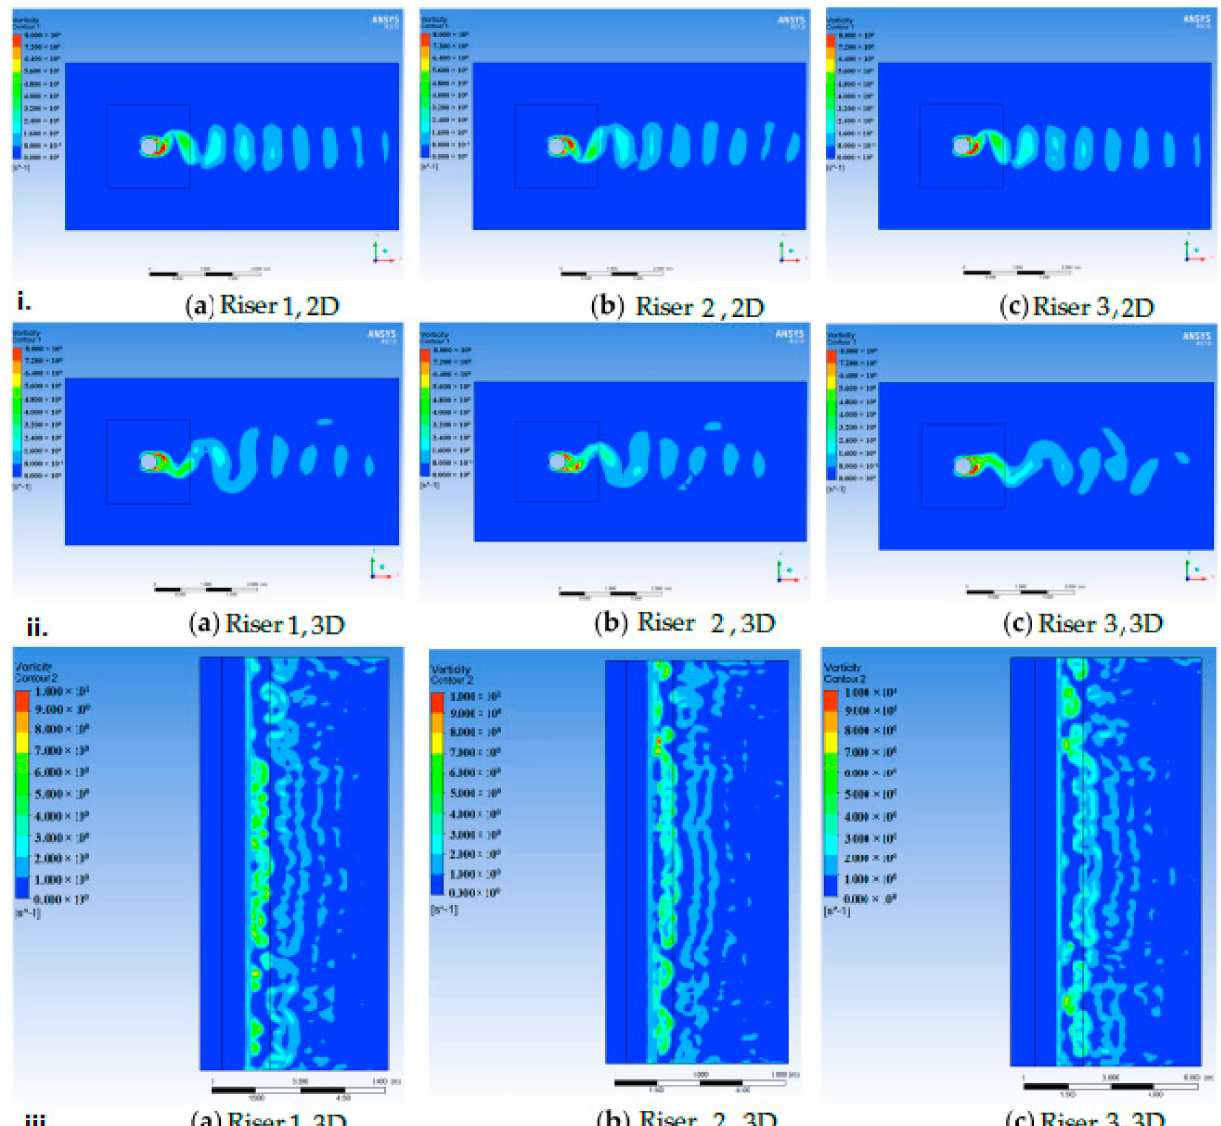
Figure 18. Profile of vorticity in 2D and 3D models for: Riser 1; Riser 2; and Riser 3. Here, ( ia – ic ) presents the vorticities for Risers 1, 2 and 3 using 2D models; ( iia – iic ) illustrates the vorticities for Risers 1, 2 and 3 with 3D models; and ( iiia – iiic ) presents vorticity profile in 3D models for (a) Riser 1; (b) Riser 2; and (c) Riser 3. (Permission to reuse was obtained from MDPI and author 5-C.W., Source: [143]; Published: 27 April 2018; Copyright date: